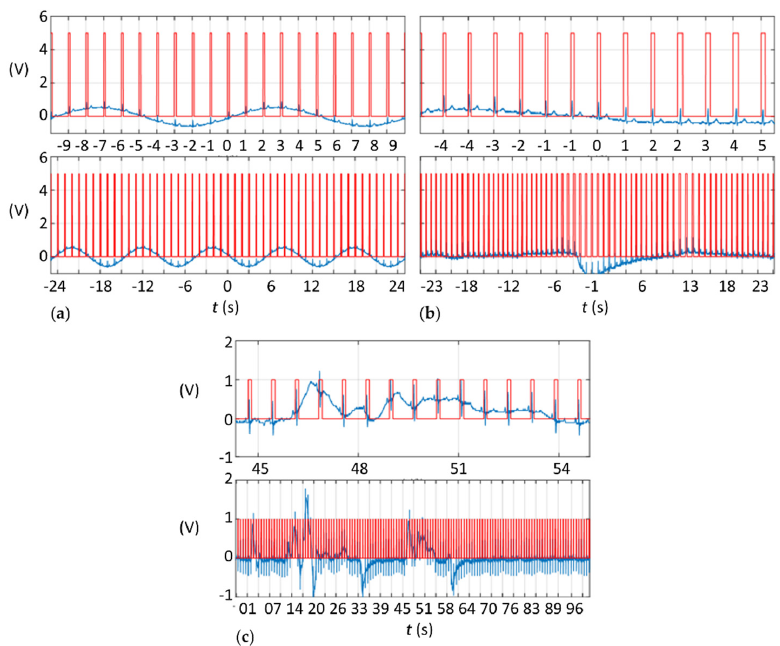
Figure 4. ECG (blue) and TTL (red) signals ( a ) when adding a sinusoidal wave to the demonstration ECG signal, ( b ) when using the ECG from a moving human patient, and ( c ) when using the ECG from an anesthetized swine specimen.